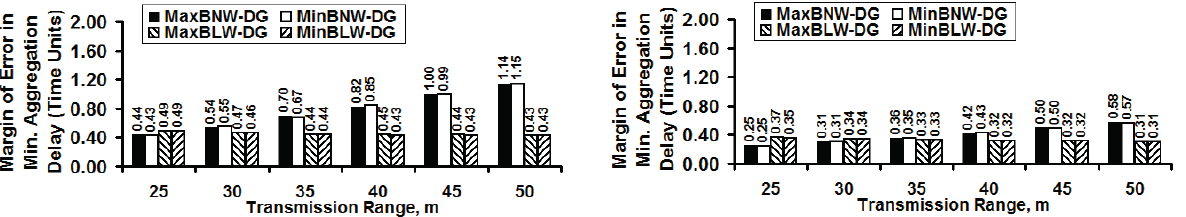
Figure 3. Margin of Error Values for Minimum Aggregation